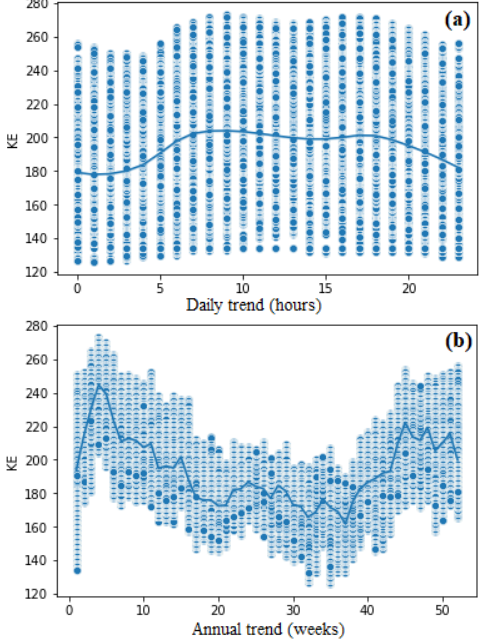
Figure 6. Seasonal trend kinetic energy: ( a ) daily and ( b ) annual.